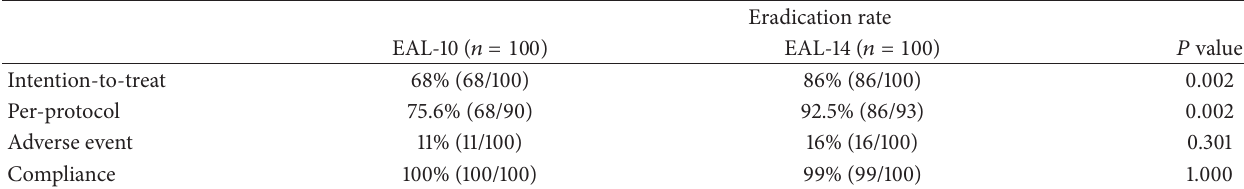
Table 2: The major outcomes of EAL-10 and EAL-14 eradication